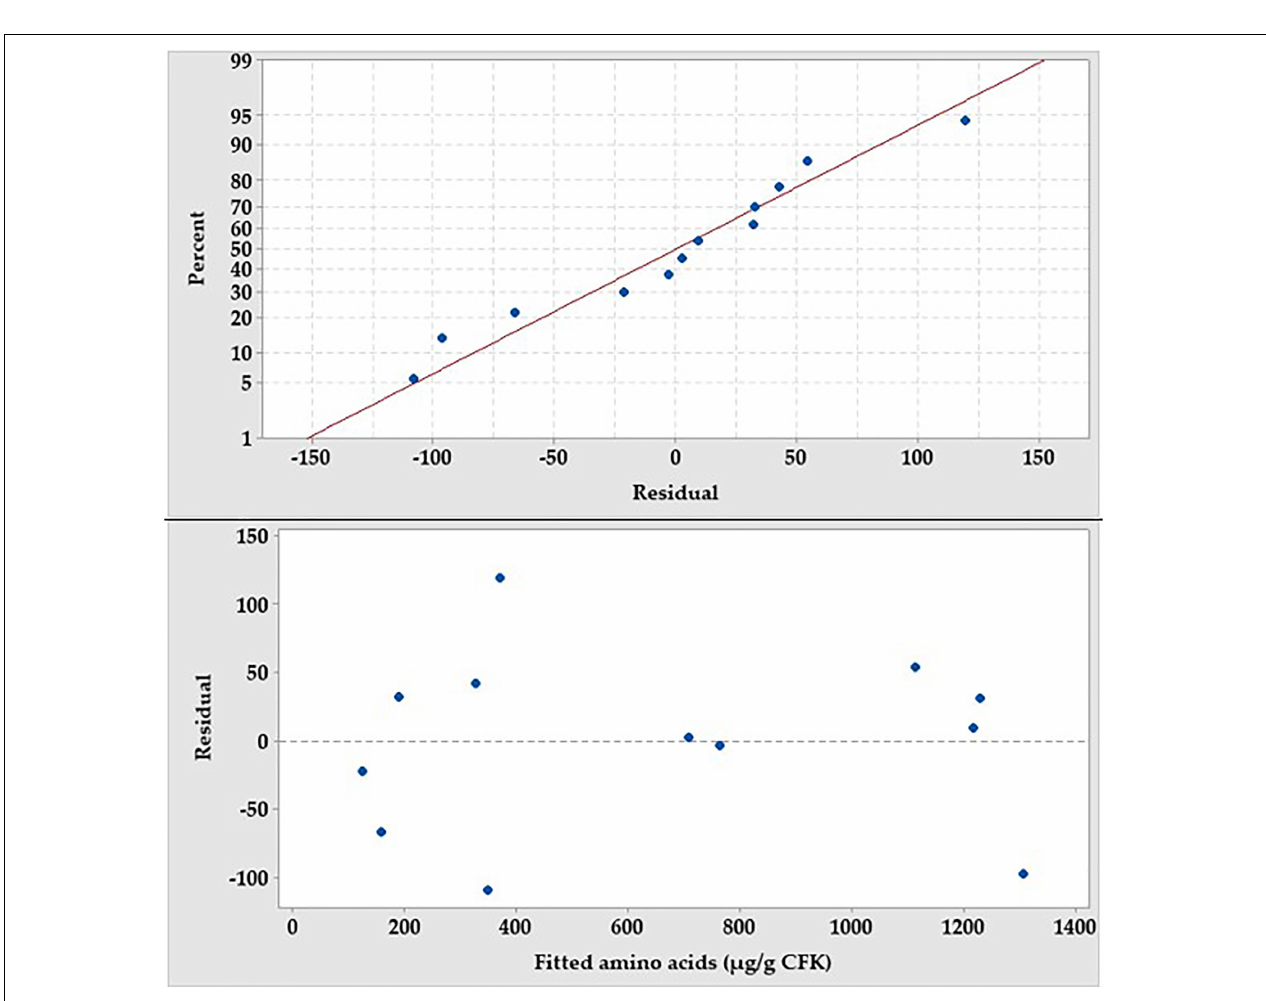
FIGURE 5 | The normal probability plot of the PB residuals and the residual versus fit plot for the production amino acids by B. paramycoides ZW-5.